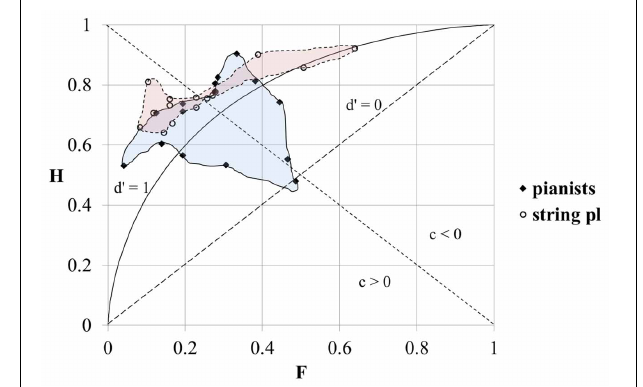
FIGURE 9 | The individual overall sensitivities of participants based on pooled replies over all test variables. The hand-drawn shapes incorporate the individual data-points of pianists (blue area) and string players (pink area). H, “hit” rate; F, “false alarm”